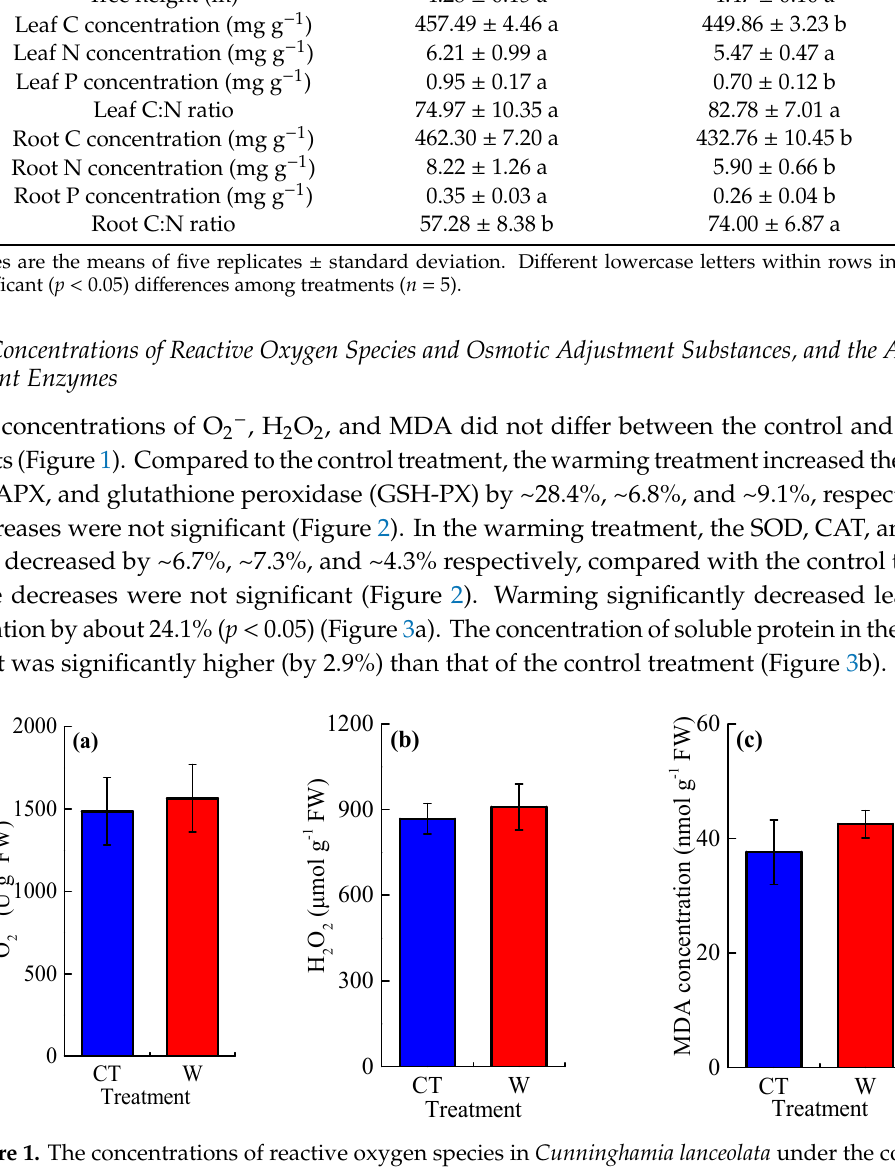
Figure 1. The concentrations of reactive oxygen species in Cunninghamia lanceolata under the control (CT) and warming (W) treatments (mean ± standard deviation, n = 5). ( a ) Superoxide anion (O 2 − ), ( b ) hydrogen peroxide (H 2 O 2 ), ( c ) malondialdehyde